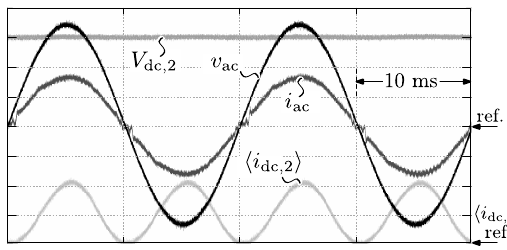
Figure 24. Measured waveforms at the ac and dc side of the converter at nominal ac input voltage of V ac = 230 V rms , nominal ac input current of I ac = 16 A rms and 450 V dc output voltage. Voltage and current scale: v ac : 100 V/div., i ac : 12.5 A/div., V dc,2 : 150 V/div., (cid:104) i dc,2 (cid:105) : 7.5